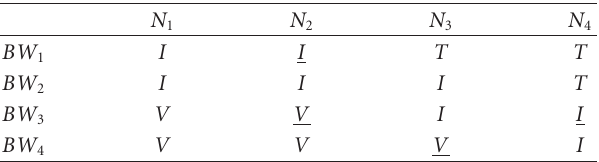
refinement for R 2 p